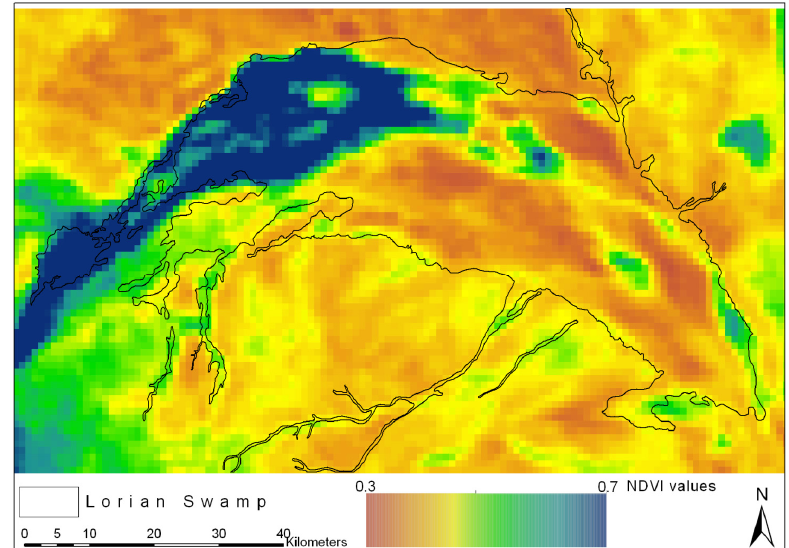
Figure 2. Boundary of the Lorian Swamp according to Africover 2000 (black line) and average SPOT VEGETATION NDVI 1998–2010, showing frequently inundated areas with high NDVI in